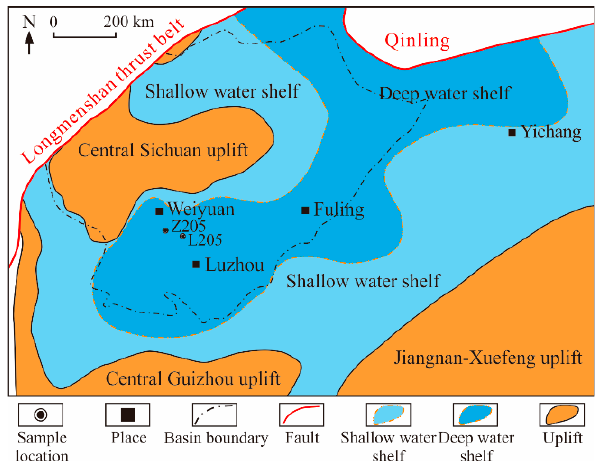
Figure 1. Sedimentary facies of Wufeng ‐ Longmaxi shale in Sichuan Basin (modified from Wang et al., 2017 [30] and Nie et al., 2020 [31]).